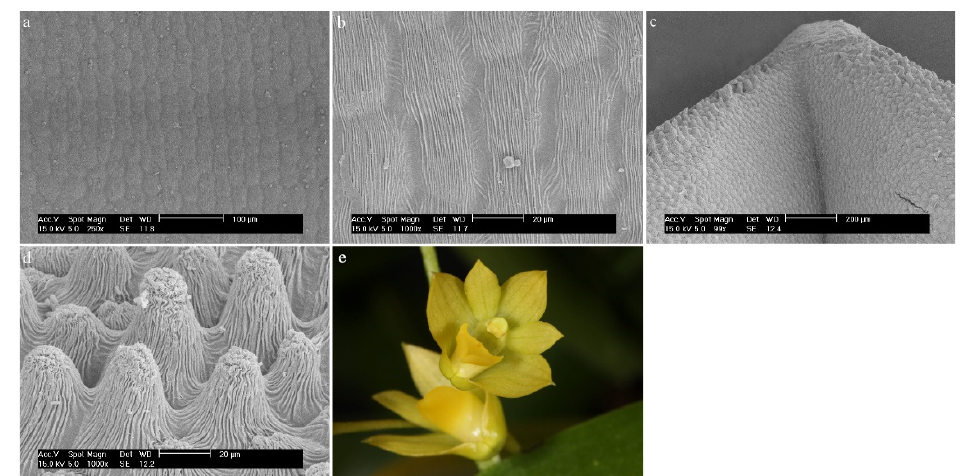
Figure 16. Dendrobium monophyllum F.Muell.: ( a , b ) the hypochile part of the labellum; ( c ) the mesochile and the epichile part of the labellum; ( d ) papillae of the margin of the epichile part of the labellum; ( e ) flower (photo by John Varigos).